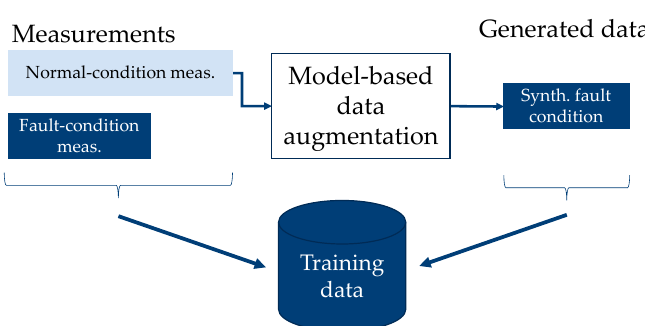
Figure 4. Generation of synthetic data and constellation of the training data when only synthetic abnormal-condition data are used to augment the training data [29].